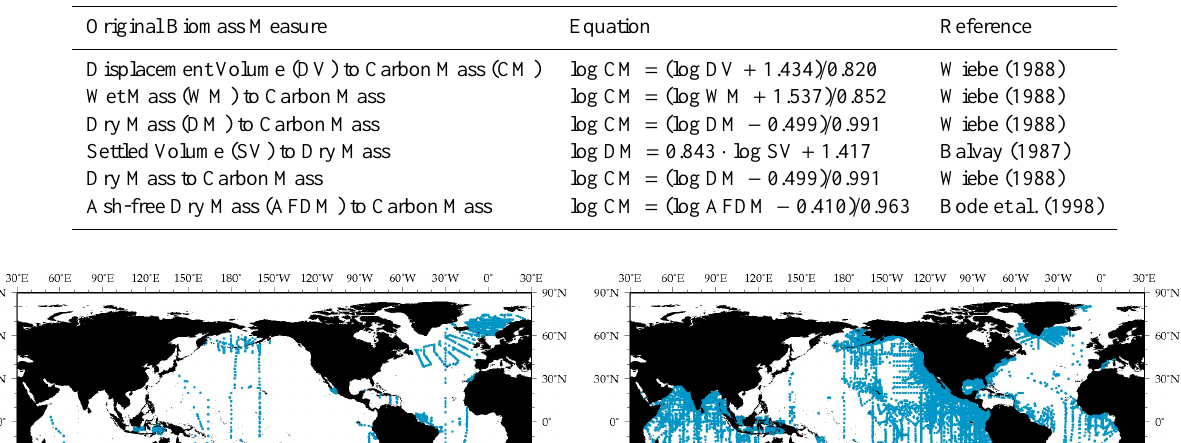
Table 2. Biomass conversion equations.